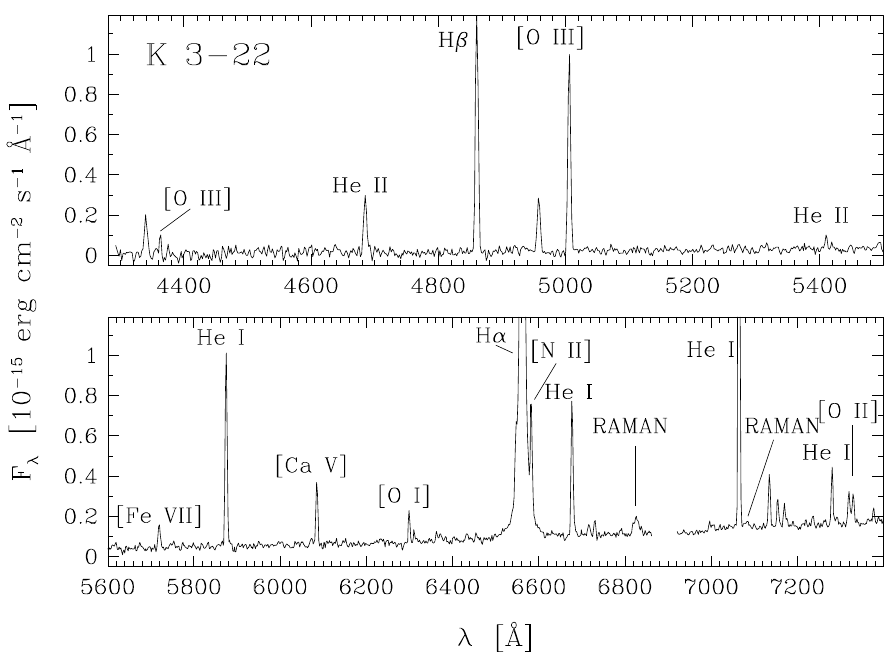
Fig. 3. The spectrum of the D-type symbiotic star IPHAS J194607.52+223112.3, previously catalogued as a possible planetary nebula and known as K 3-22 ((cid:12)gure adapted from Corradi & Giammanco